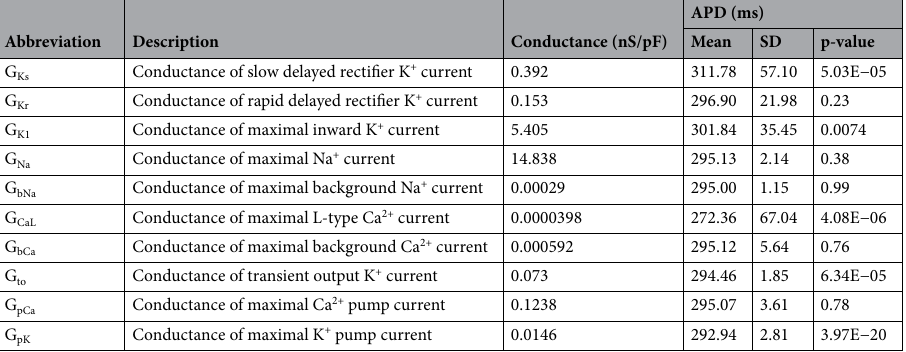
Table 1. Statistics of APDs based on ion channel conductance.